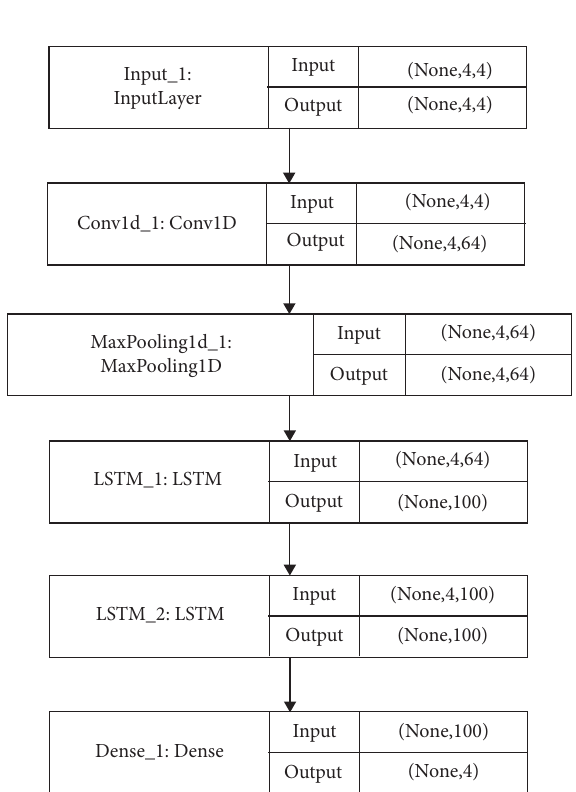
Figure 4: Basic structure of the proposed multivariate CNN-LSTM model for multiple time-series prediction with 4 features and 4-time steps for the prediction